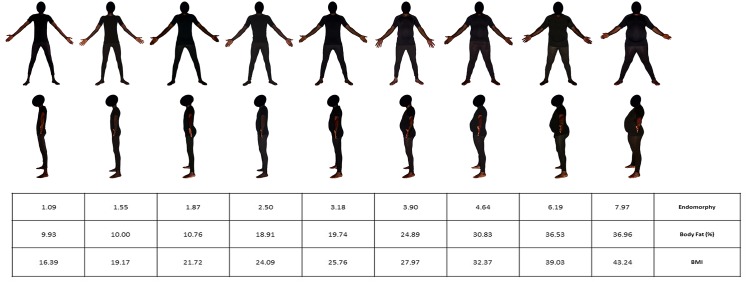
Male Body Size Scale.The scale shows 9 Black male models from front and left side-views, and ordered by increasing adiposity. The table gives the levels of endomorphy component, body fat percentage and body mass index corresponding to each model.